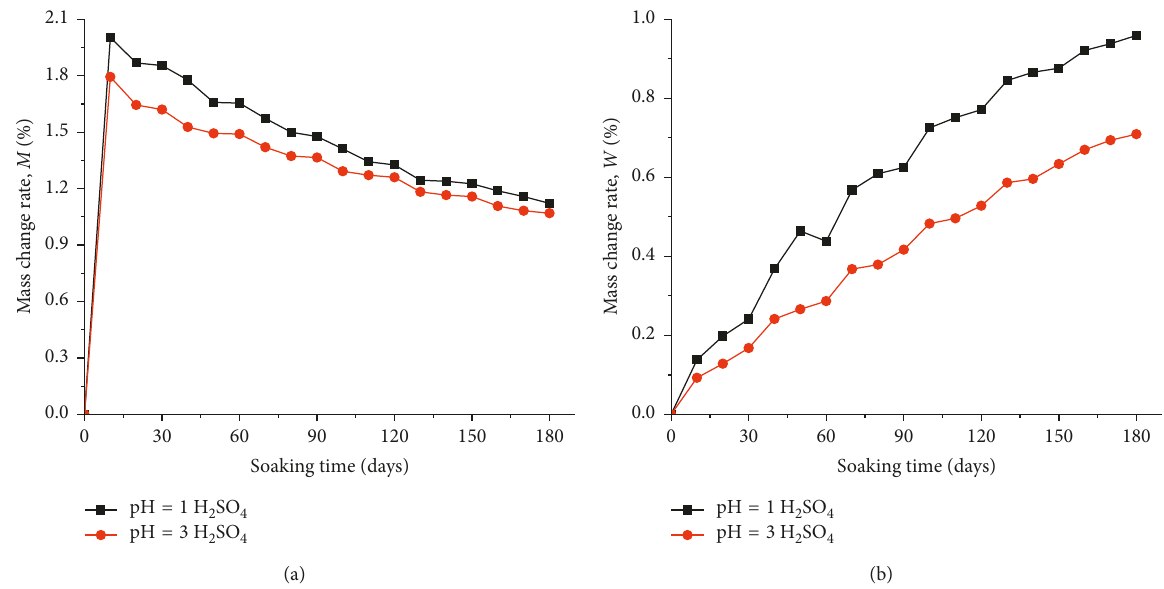
Figure 6: Mass change rate curves of the sandstone samples in different pH solutions: (a) wet samples and (b) dry